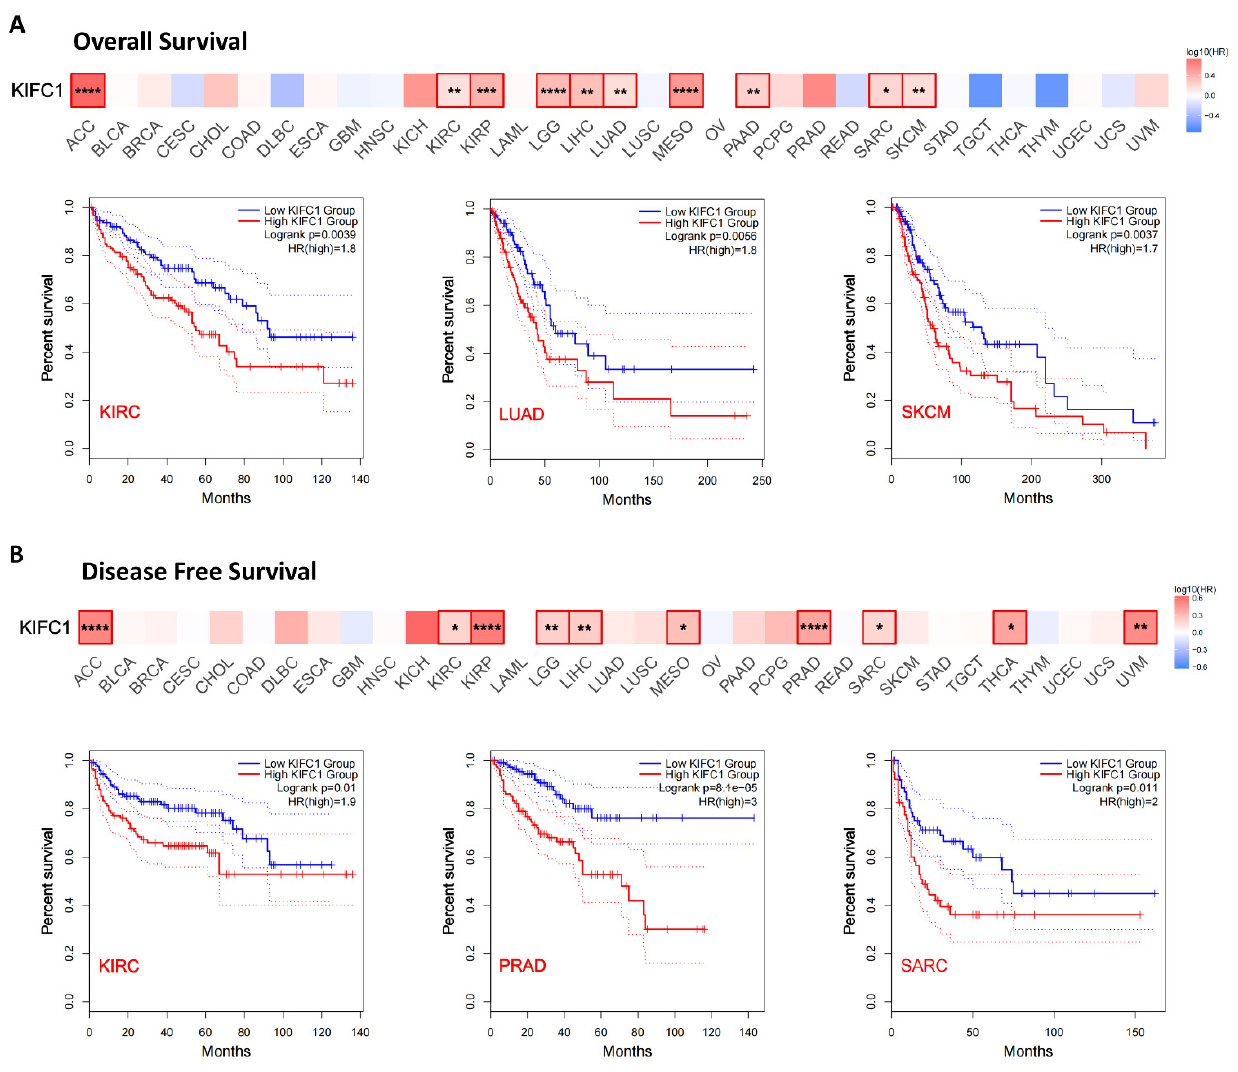
Figure 4. Relations between KIFC1 expression and survival prognoses of different tumors in TCGA database are shown in survival maps and with Kaplan–Meier curves. GEPIA2 tool was used to obtain ( A ) the overall survival, and ( B ) disease-free survival analyses. High-cutoff (50%) and low-cutoff (50%) values were used as the expression thresholds for separating the high-expression and low-expression cohorts. * p < 0.05, ** p < 0.01, *** p < 0.001, **** p < 0.0001, in log-rank test. HR: hazard ratio.